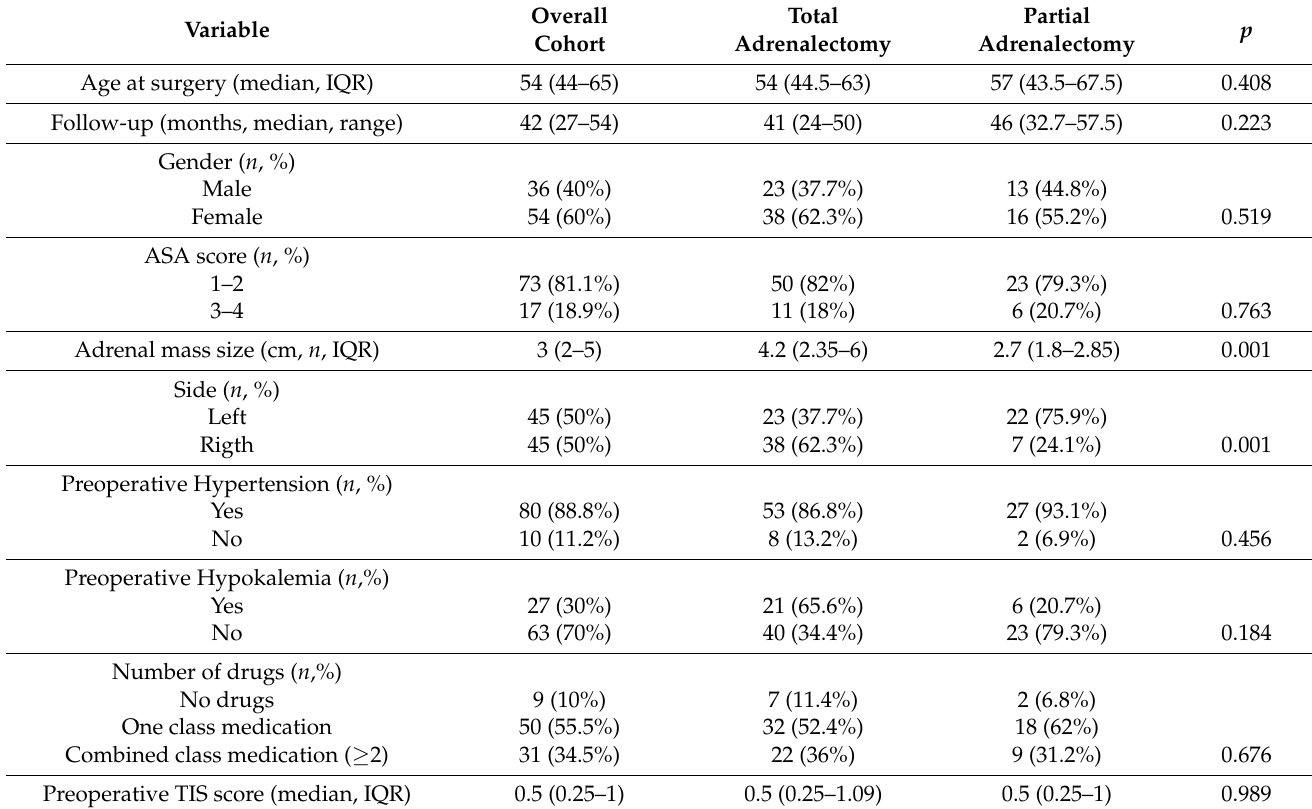
Table 2. Baseline and preoperative